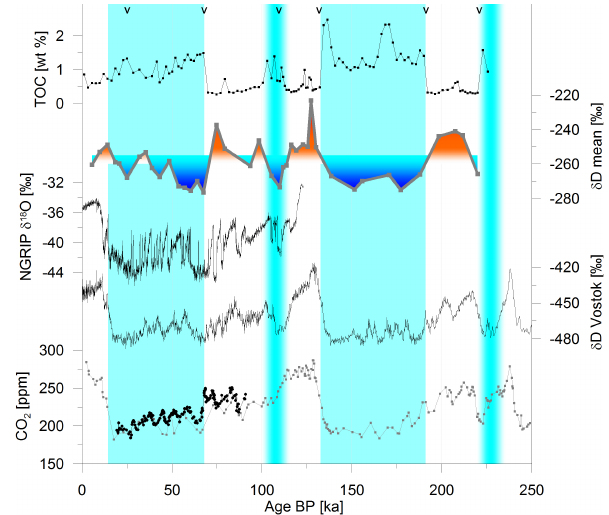
Fig. 4. The Tumara Paleosol record in its paleoclimatic context. The TOC concentration and the mean δ D values are compared to temperature proxies from Greenland (NGRIP δ 18 O) (NGRIP mem- bers, 2004) and Antarctica ( δ D Vostok) (Petit et al., 1999), and to atmospheric CO 2 (Ahn and Brook, 2008; Petit et al., 1999). The triangles mark the tie points used to establish the age-depth